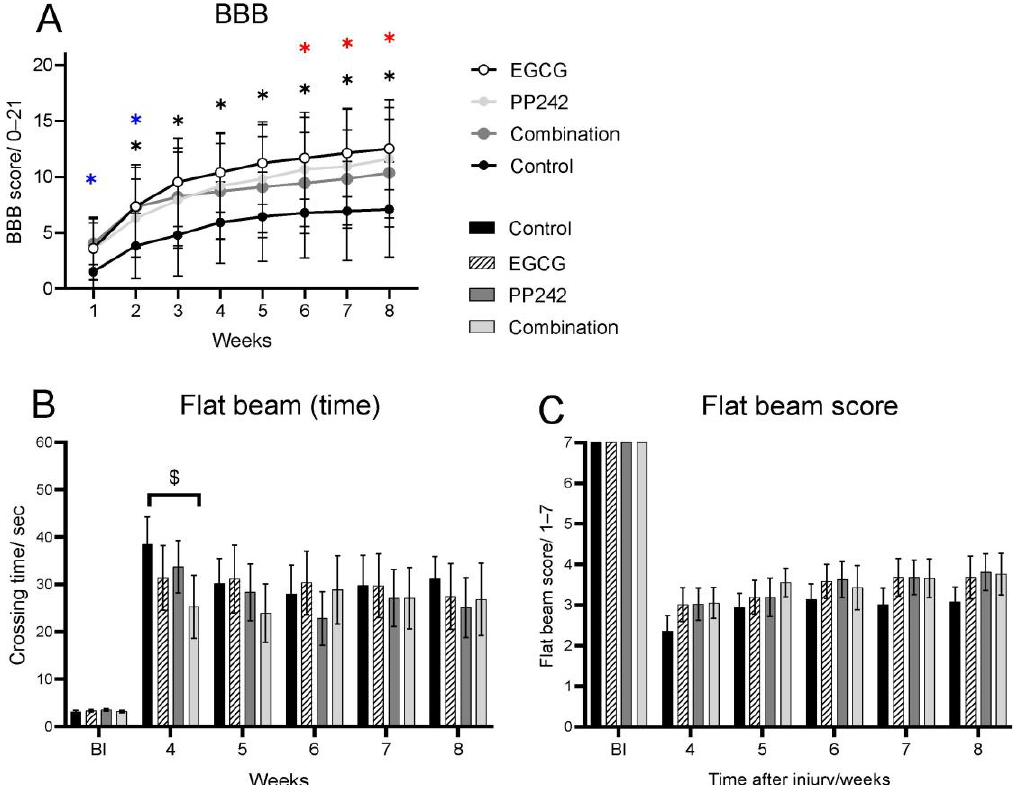
Figure 1. BBB and flat beam test in rats treated with vehicle, EGCG, PP242, and EGCG+PP242 ( A